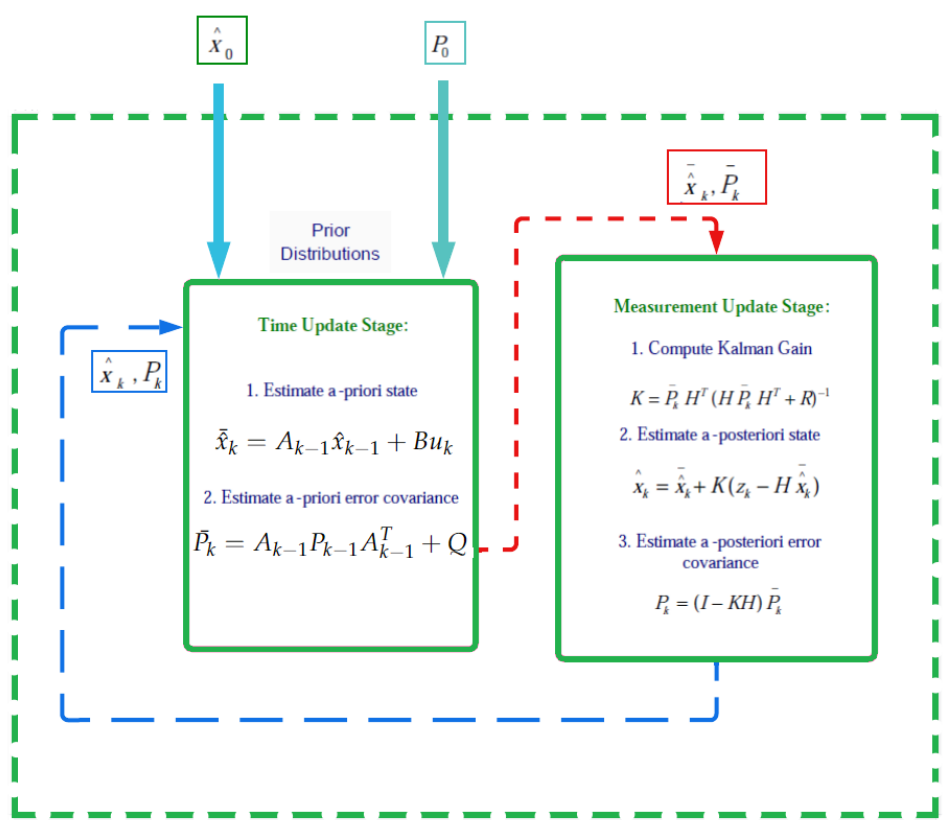
Figure 1. SDKF algorithm